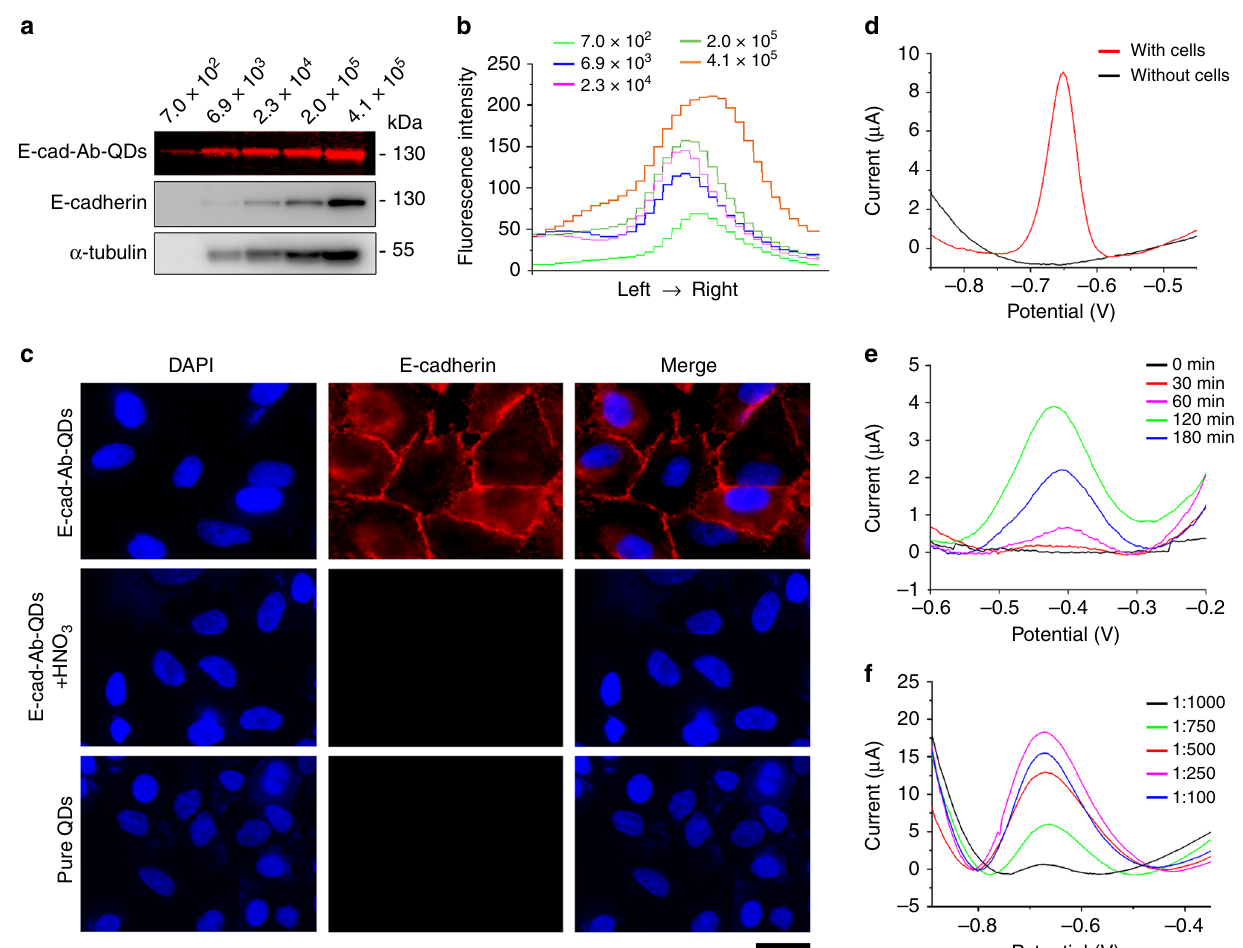
Fig. 3 Speci fi city and sensitivity of the prepared probe. a Immunoblotting of E-cadherin with the E-cad-Ab-QD probe and standard E-cadherin antibodies using different amount of A549 cells. b Fluorescence intensity curves of E-cadherin from different amount of cells. c Immuno fl uorescence microscopy of A549 cells stained with the E-cad-Ab-QD probe, the E-cad-Ab-QD probe with HNO 3 solution, and pure QDs. Scale bar, 25 μ m. d Response currents of the electrochemical biosensor measured with or without A549 cells by DPV. e Optimization of the incubation time for the E-cad-QD probe. f Optimization of the E-cad-Ab-QD probe concentration for detecting E-cadherin. Source data are provided as a Source Data fi cyclic voltammetry, which demonstrated an apparent redox peak ascribed to a ferricyanide ion for each modi fi ed electrode (Fig. 2e).